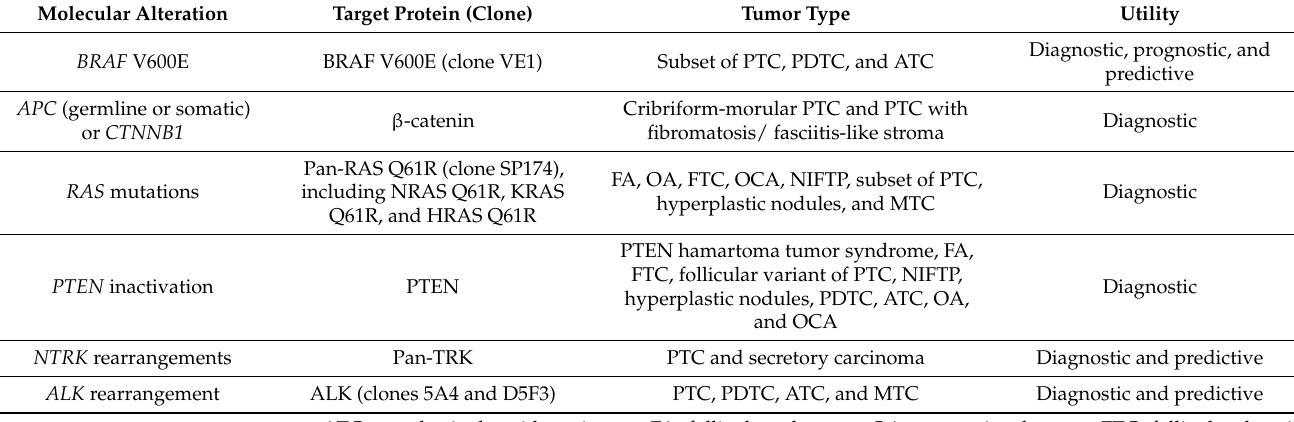
Table 3. Immunohistochemistry for the detection of molecular alterations in thyroid